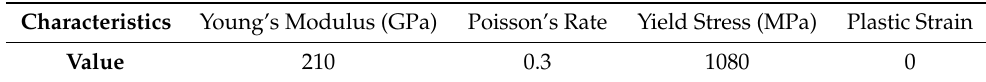
Table 5. The mechanical properties of bolts.